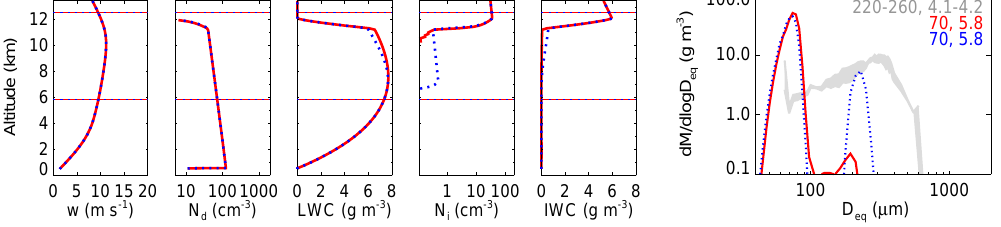
Figure 5. As in Fig. 4 for simulations that also include 1stdcm − 3 of immersion-mode IFN (red solid line) or pseudo-Hallett–Mossop embryos (blue dotted line), both with baseline updraft. Details provided in